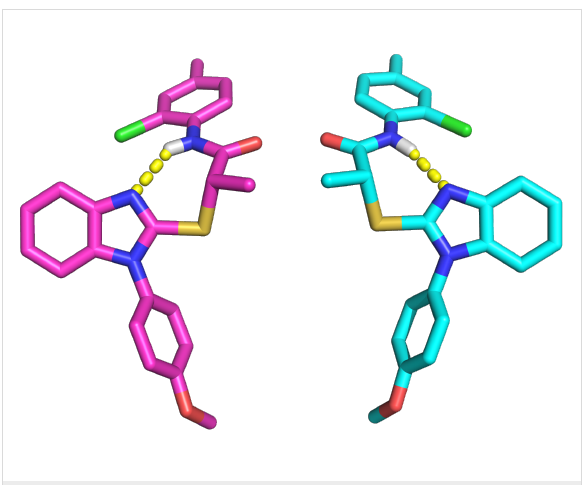
Figure 2: Renderings of crystal structures of ( S ) - (left, magenta) and ( R ) - (right, cyan) enantiomers of 1 .